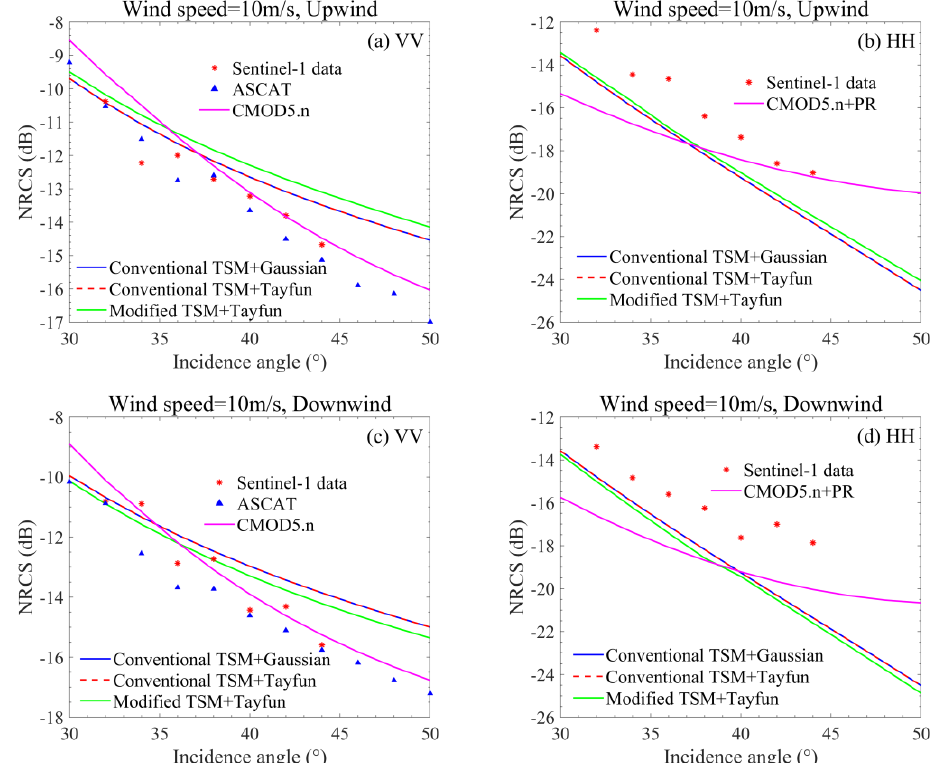
Figure 8. The simulated average NRCSs based on the conventional TSM + Gaussian sea surface, conventional TSM + Tayfun sea surface, and modified TSM + Tayfun sea surface and their comparison with the reference data at a 10 m/s wind speed as functions of the incidence angle ( a , b ) in the upwind direction under VV and HH polarizations and ( c , d ) in the downwind direction under VV and HH polarizations. Blue solid curve, the conventional TSM + Gaussian sea surface; red dashed curve, the conventional TSM + Tayfun sea surface; green solid curve, the modified TSM + Tayfun sea surface; red star, the Sentinel-1 data; blue triangle, the ASCAT; magenta solid curve, the